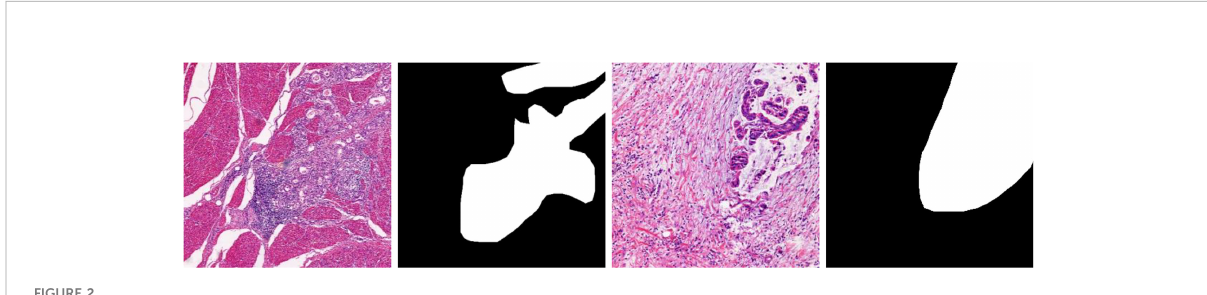
FIGURE 2 Example images and masks of the SEED